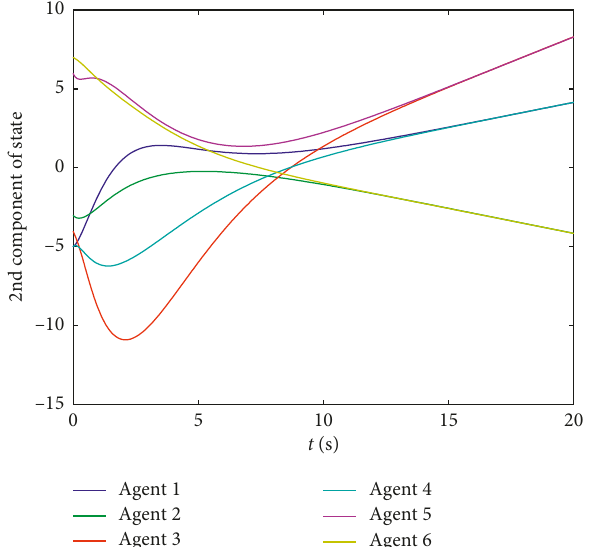
Figure 2: Trajectories of x